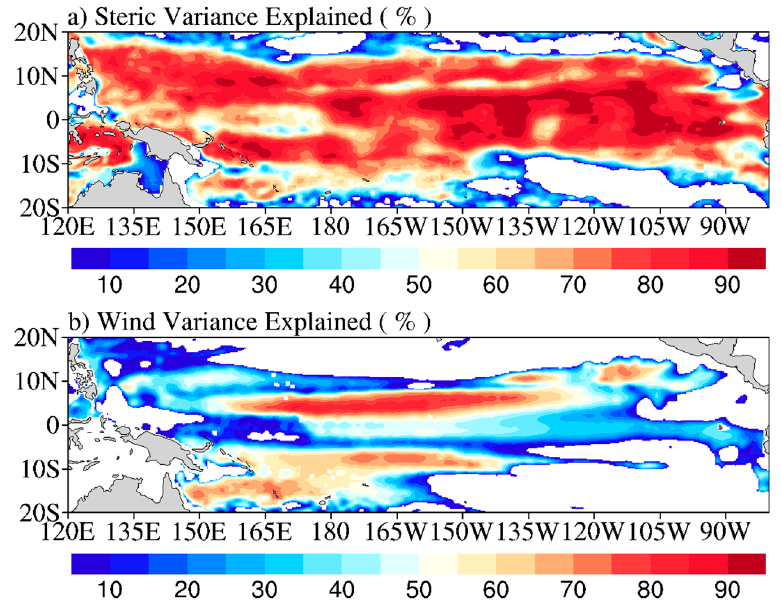
Figure 2. The seasonal sea level explained variances of ( a ) the steric effect and ( b ) the dynamic pro- cess.